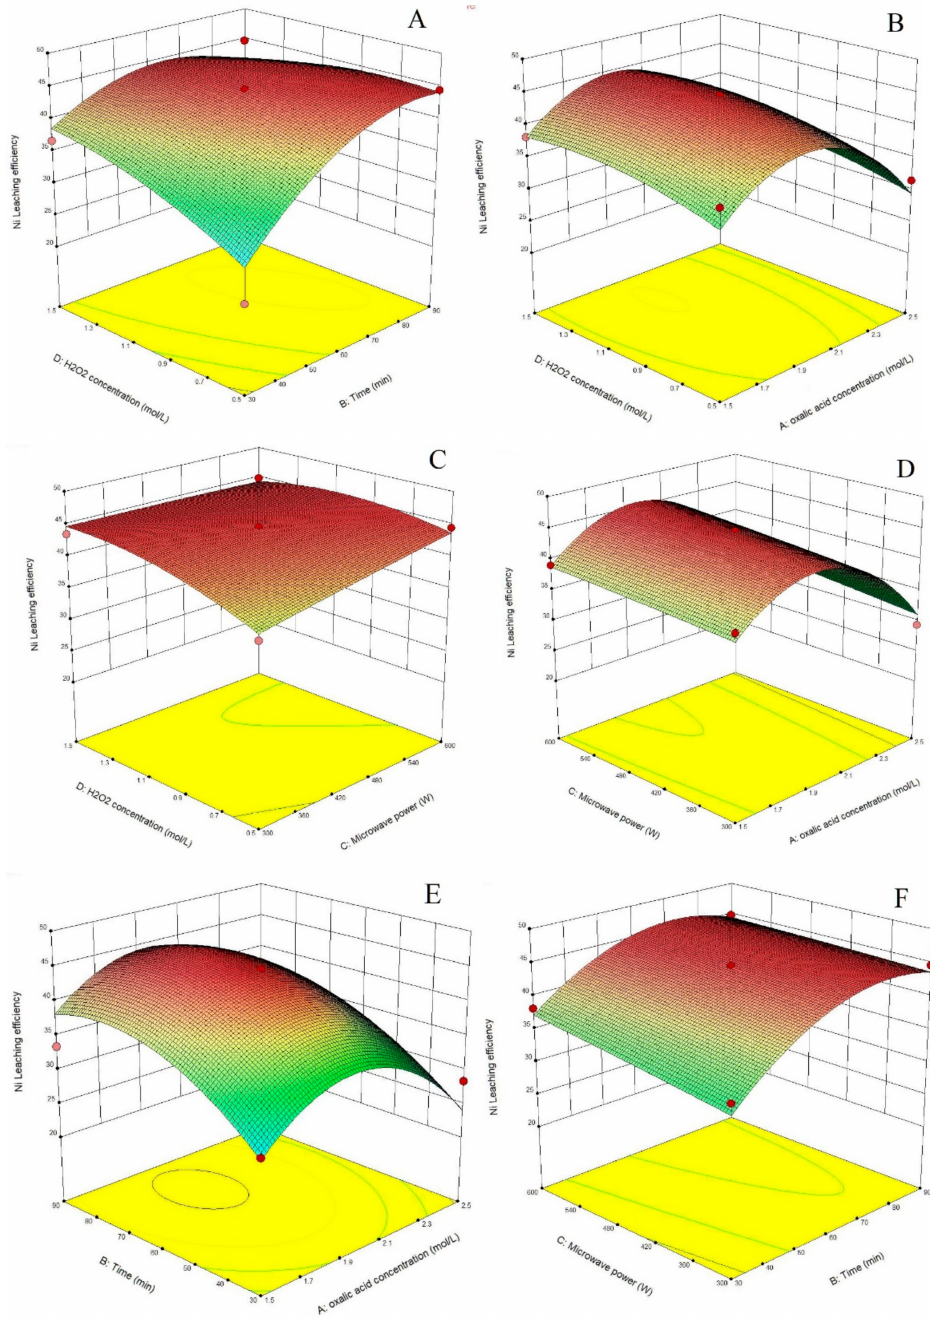
Figure 6. 3D response surface plots of the effect of various parameters on Ni extraction: ( A ) Relation- ship of H 2 O 2 concentration and leaching time; ( B ) Relationship of H 2 O 2 concentration and C 2 H 2 O 4 concentration; ( C ) Relationship of H 2 O 2 concentration and microwave power; ( D ) Relationship of C 2 H 2 O 4 concentration and microwave power; ( E ) Relationship of C 2 H 2 O 4 concentration and leaching time; ( F ) Relationship of leaching time and microwave